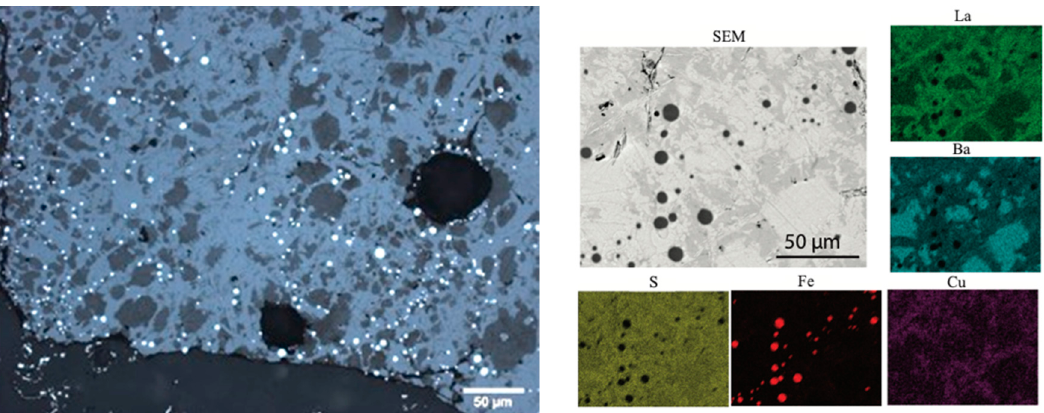
Figure 3. Iron-rich metallic product found on the graphite cathode after the electrochemical decom- position of CuFeS 2 concentrate in BaS-La 2 S 3 supporting electrolyte, at 300 mA scale show in optical image ( left ) and SEM-EDS mapping ( right ). EDS analysis confirmed the cathodic product is iron-rich (>95%) with <5 wt% copper.